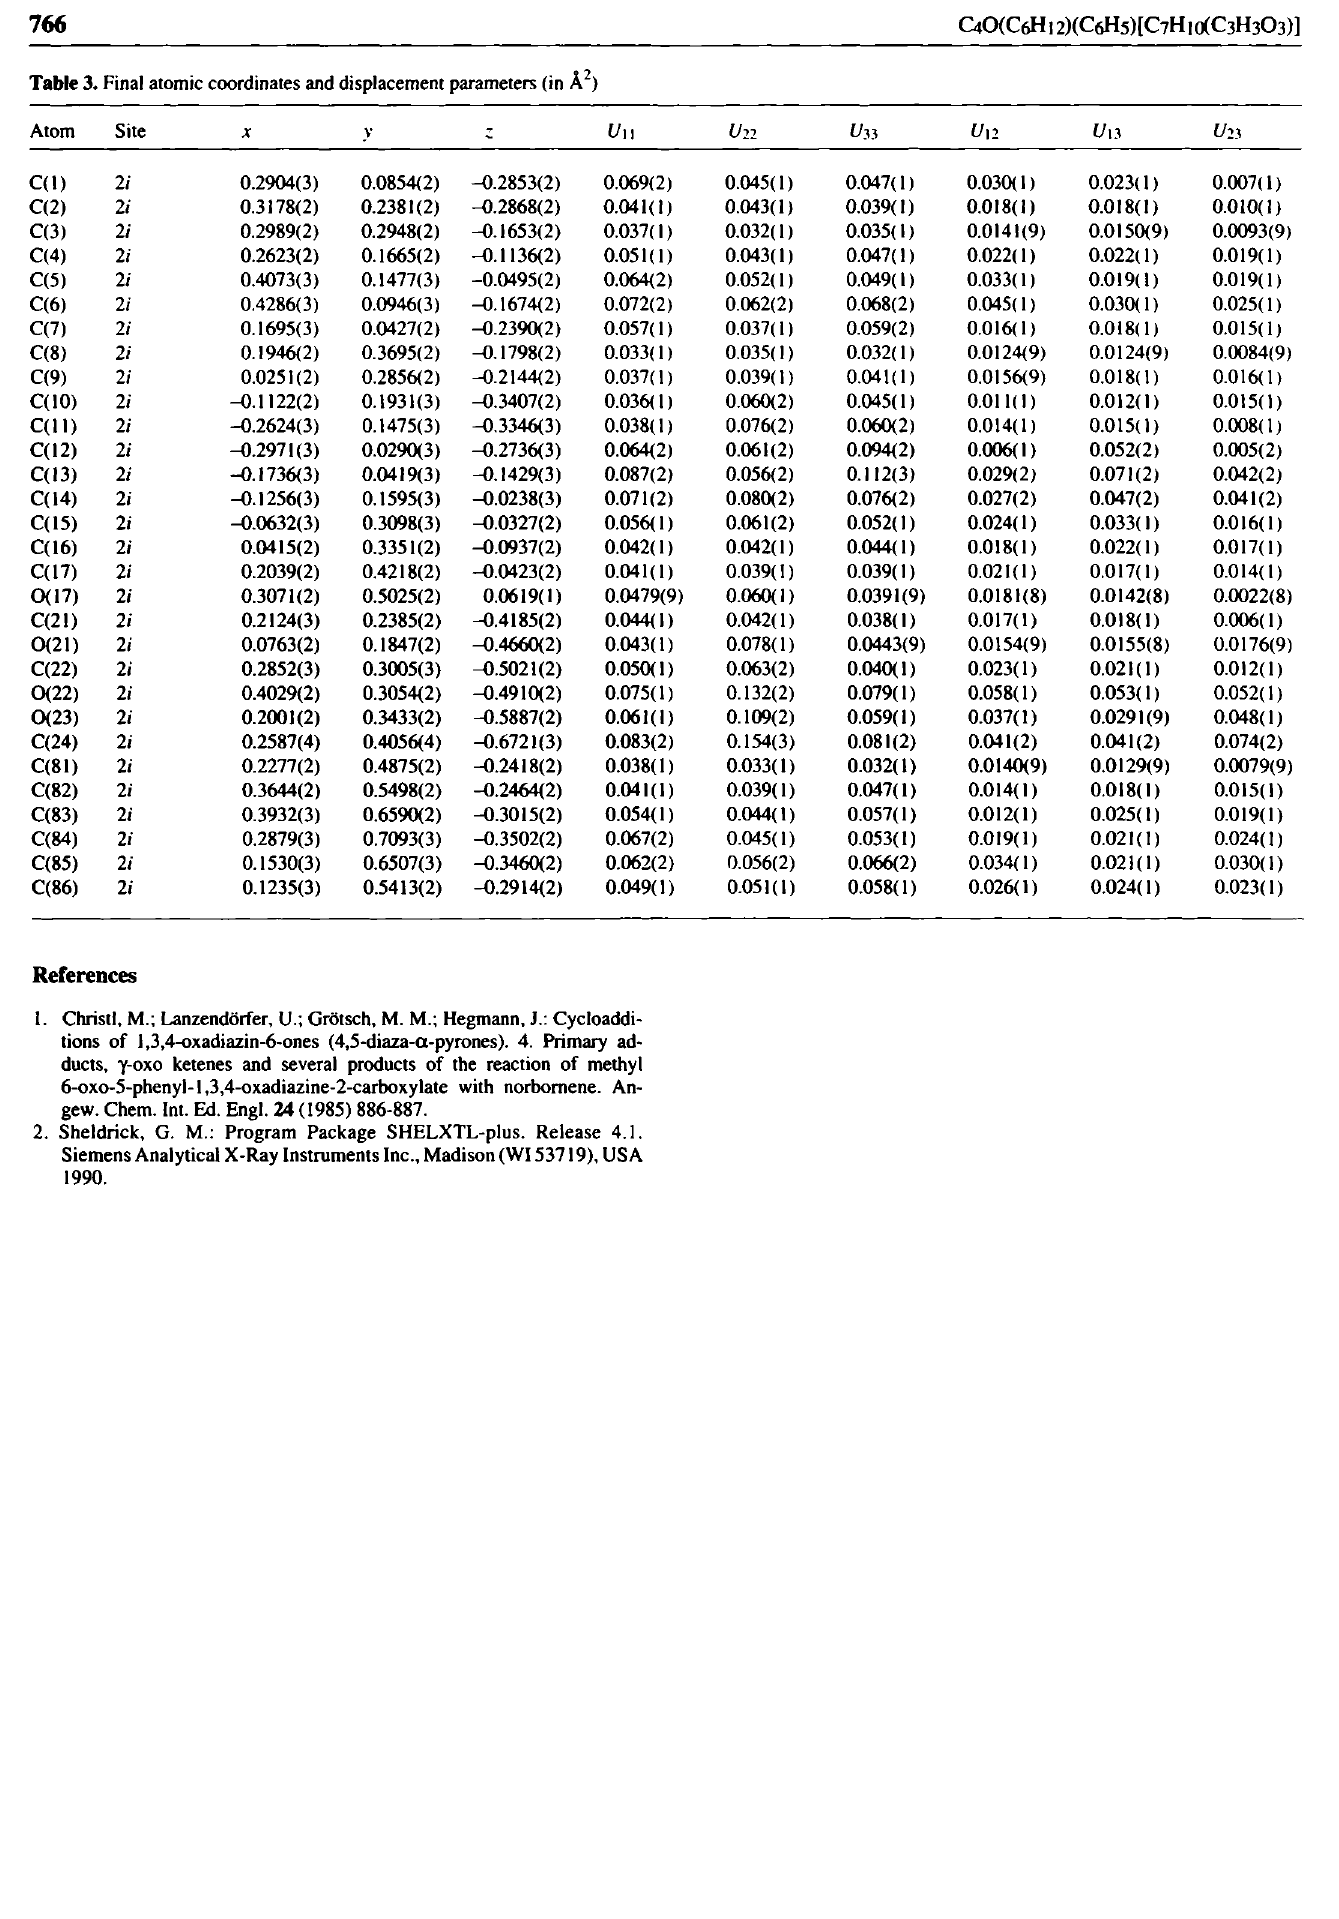
Table 3. Final atomic coordinates and displacement parameters (in A^) Atom